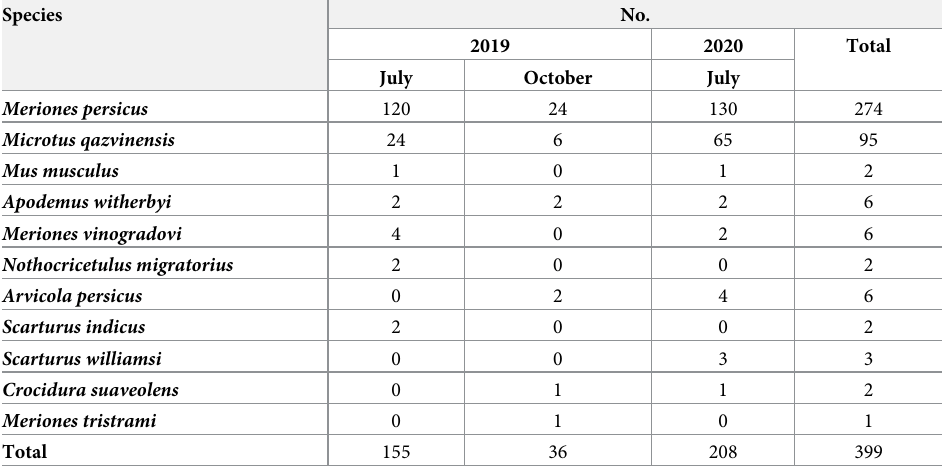
Table 2. Scientific name and number of the small mammals surveyed in the present study from Takestan county, Qazvin province in 2019–2020.